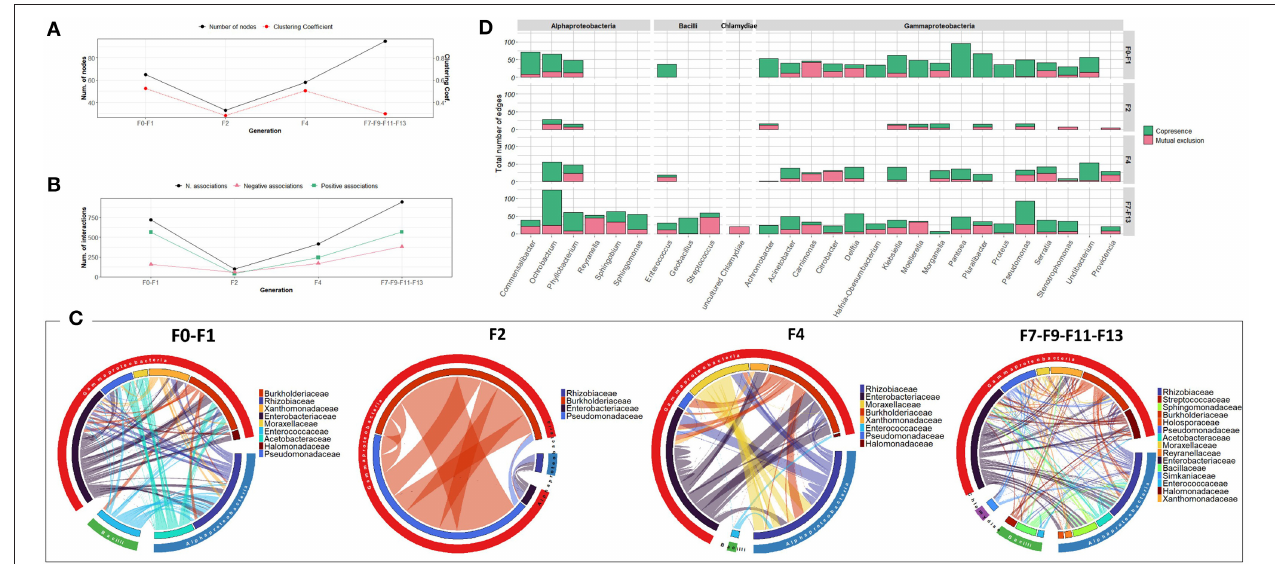
FIGURE 2 | Bacterial community network within the guts of C. capitata larva during laboratory adaptation of Vienna 8 FD-GSS strain. (A) Total number of nodes and clustering coefficient. (B) Total number of negative (red) and positive (green) associations, (C) Chord diagram displaying direct relationship between OTUs at family level. The size of the ribbon is proportional to the weight of the association between the OTUs assigned to the respective segments and the color of the ribbon present in the direction of the interaction. (D) Number of positive and negative associations at genus